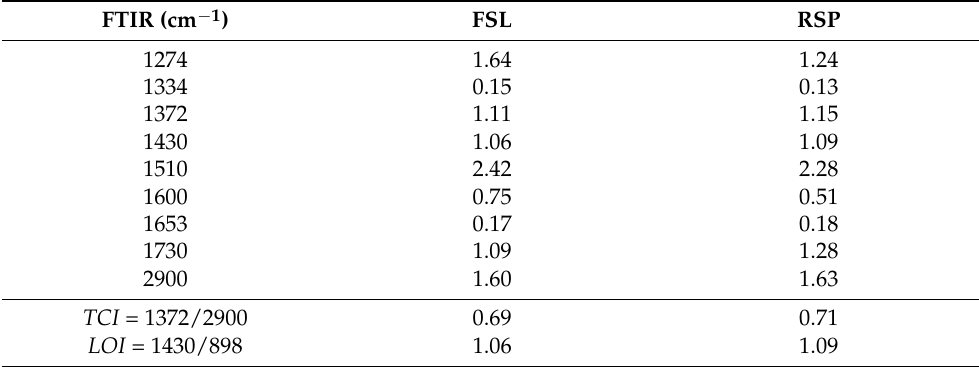
Table 1. Intensity of FTIR spectra (normalized at 898 cm − 1 ) for particles from the fresh spruce logs (FSL) and the recycled spruce pallets (RSP).